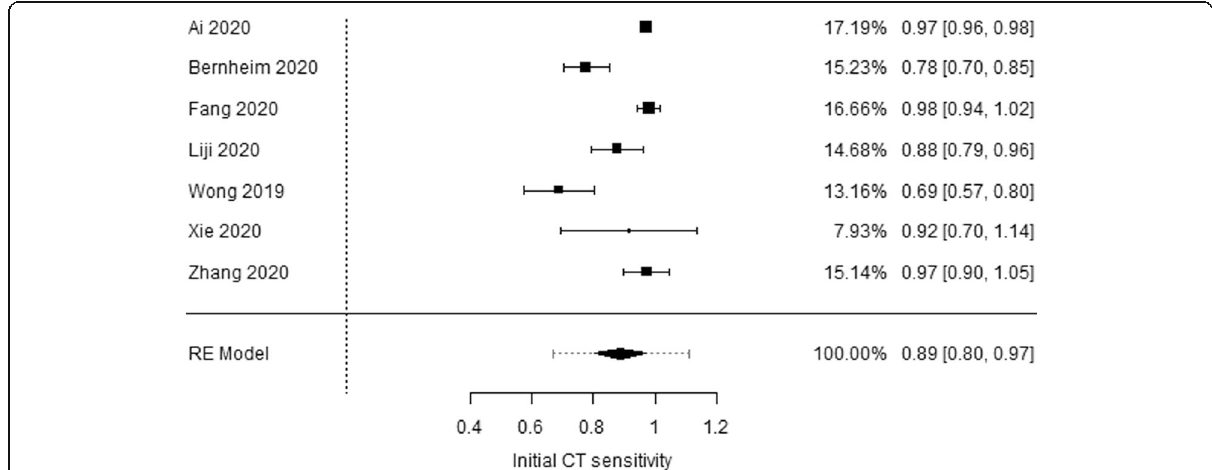
Fig. 1 Forest plot for sensitivity of initial CT scan. There is considerable heterogeneity across studies (Cochran Q test P value < 0.001, I -squared = 94.2%). Pooled sensitivity = 89% (95% CI = 80 to 97%). Prediction interval is presented as a dotted extension up and down the 95% confidence limits of pooled effect size [11 –